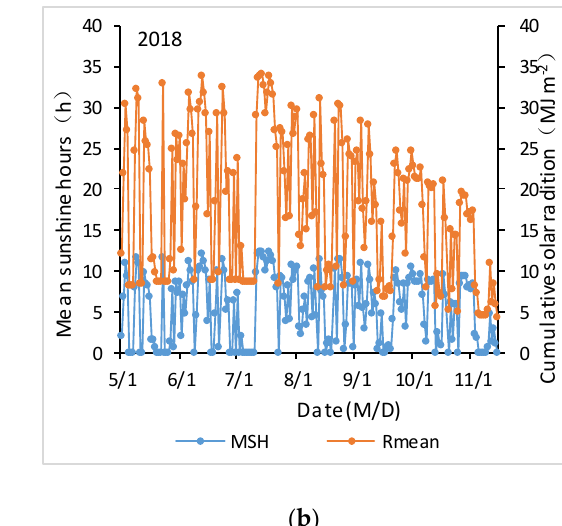
( b ) Figure 4. Variation of relative humidity during rice growing season. MRH, mean relative humidity; DH, daytime relative humidity; NH, night relative humidity. ( a ): 2017; ( b ): 2018. 3.2. Difference of Main Meteorological Indicators in Different Growth Stages of Rice According to the variation characteristics of T mean , T max , T min , DT, NT, MSH, R mean , MRH, DH, NH, and MDR, we selected four meteorological indicators, T mean , R mean , MRH, and MDR, as the main meteorological indicators to study the differences of meteorological indicators in rice growth stages under seven sowing time treatments. The late-maturing japonica soft rice (SLR) and late-maturing japonica non-soft rice (LR) had similar phenological periods under the same sowing time treatment. Both the SLR and LR failed to fully mature in varieties T5, T6, and T7. The harvest date (November 8) was considered the deadline for rice growth and was used to calculate the T mean , effec- tive accumulated temperature (EAT), R mean , and cumulative solar radiation (CSR). In the analysis of meteorological indicators, SLR and LR were analyzed as the same growth type. The linear model demonstrated that the T mean , EAT, R mean , and CSR from the heading to maturity stages of medium-maturity japonica soft rice (SMR) decreased by 1.0–1.1 °C, 53.2– 55.1 °C, 0.5–0.6 MJ m − 2 , and 16.9–24.1 MJ m − 2 , respectively, when the sowing date was